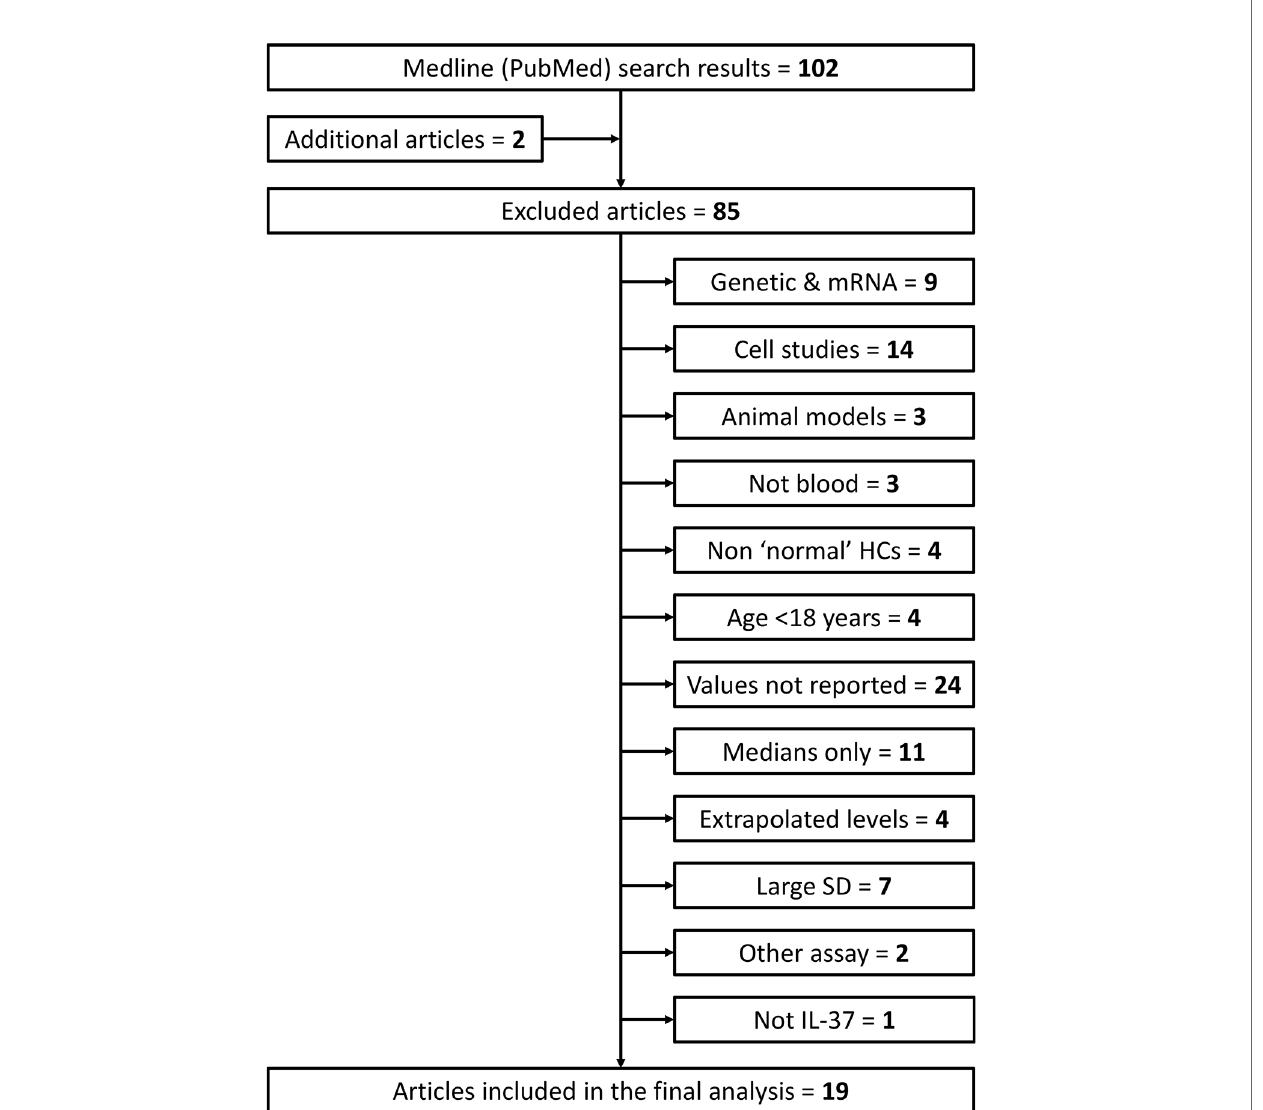
FIGURE 2 | Flow diagram of search results and article screening, exclusion and inclusion for analysis of circulating IL-37 in healthy adult humans. Additional articles were found by reviewing the ‘ Similar Articles ’ listed on abstract pages on PubMed. HCs, healthy controls; SD, standard